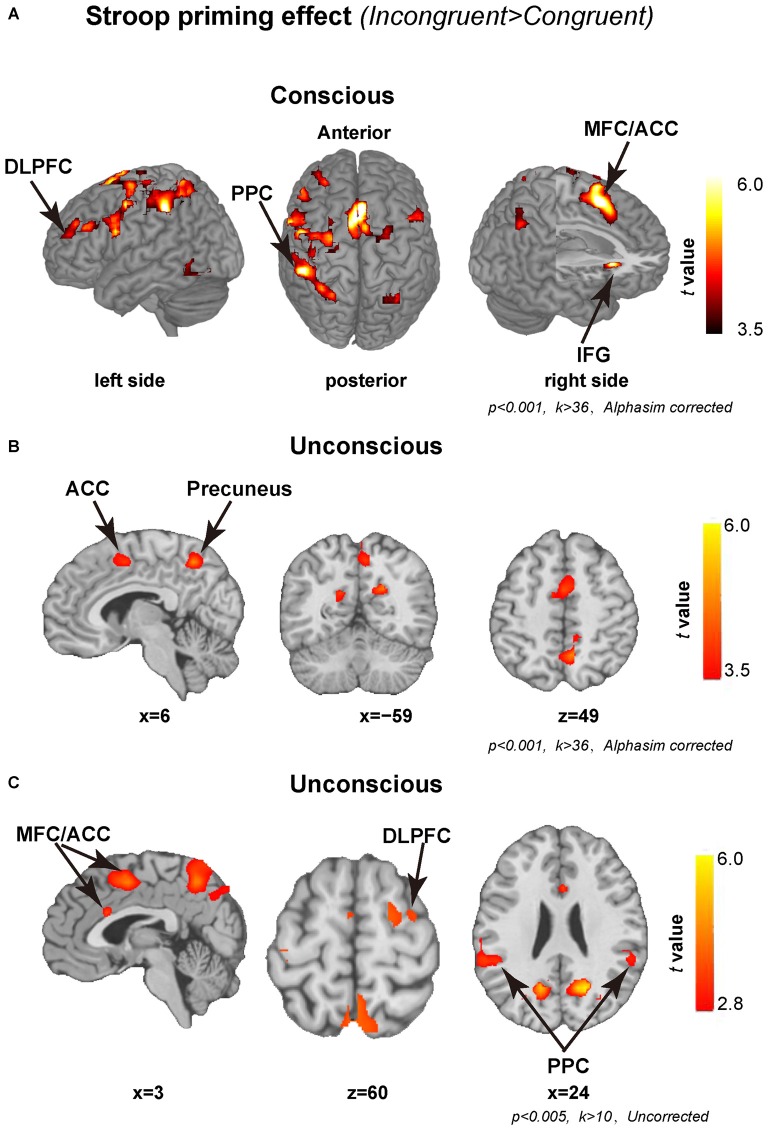
Brain regions showing significant activation by conscious and unconscious Stroop priming effects. (A) Regions showing significant activation by conscious Stroop priming effect. (B) Regions showing significant activation by unconscious Stroop priming effect. The statistical thresholds were set at p < 0.001 with a minimum cluster size of 36 voxels using the AlphaSim Monte Carlo simulation in (A,B). (C) Brain regions showing significant activation by unconscious Stroop priming effects. The statistical thresholds were set at p < 0.005 with a minimum cluster size of 10 voxels, uncorrected. DLPFC, dorsal lateral prefrontal cortex; PPC, posterior parietal cortex; ACC, anterior cingulate cortex; MFC, medial frontal cortex.